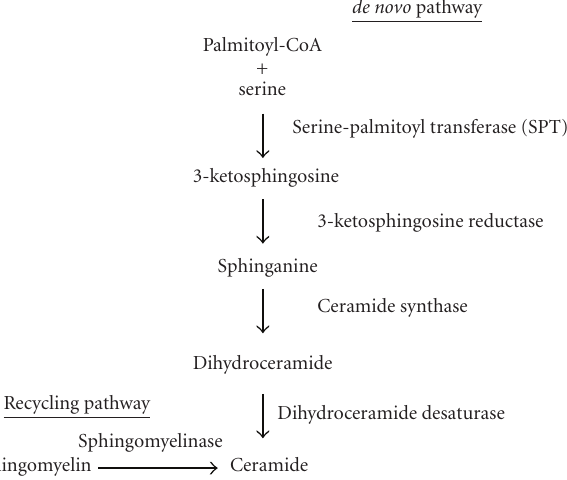
Figure 1: Synthesis pathway of ceramide. There exist two pathways for ceramide synthesis: de novo pathway and recycling pathway. The de novo pathway occurs in the endoplasmic reticulum while the recycling pathway occurs in vesicular and cell